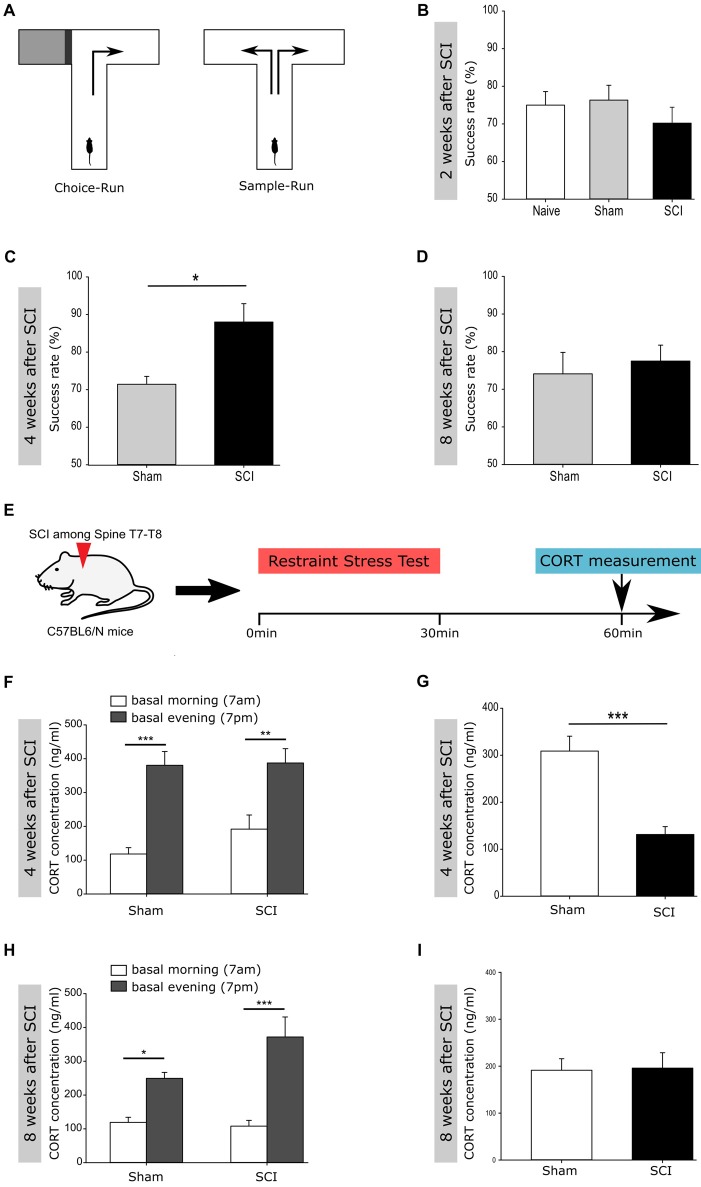
Improved performance in a Working Memory task and in buffering acute stress following spinal cord injury. (A) Experimental setup for the spontaneous alternation in the T-Maze test. (B) Success rate 2 weeks post injury of naïve vs. sham vs. SCI mice (75% ± 3.29 vs. 76.34% ± 3.80 vs. 70.19% ± 4.09); nnaive = 6 vs. nsham = 14 vs. nSCI = 13. (C) Success rate 4 weeks post injury of sham vs. SCI mice (71.43% ± 5.15 vs. 88% ± 4.38); group size, nsham = 7 vs. nSCI = 5; Mann-Whitney Rank Sum Test. (D) Success rate 8 weeks post injury of sham vs. SCI mice (74.11% ± 5.27 vs. 77.5% ± 3.79); group size, nsham = 7 vs. nSCI = 5. (E) Experimental setup to perform the restraint stress test. (F) Basal corticosterone (CORT) concentration 4 weeks post injury in shammorning vs. shamevening (118.2 ± 18.7 vs. 380.6 ± 40.9 ng/ml) and SCImorning vs. SCIevening (191.7 ± 42 vs. 387.5 ± 42.3 ng/ml); nsham = 14 vs. nSCI = 14; one way ANOVA. (G) CORT concentration 4 weeks post injury after the restraint stress test in sham vs. SCI mice (309 ± 31.6 vs. 131.3 ± 16.8 ng/ml); nsham = 14 vs. nSCI = 14; Mann-Whitney Rank Sum Test. (H) Basal CORT concentration 8 weeks post SCI in shammorning vs. shamevening (119 ± 15.2 vs. 249.5 ± 17.6 ng/ml) and SCImorning vs. SCIevening (108 ± 17 vs. 371.9 ± 59.1 ng/ml); nsham = 13 vs. nSCI = 13; one way ANOVA. (I) CORT concentration 8 weeks post SCI after the restraint stress test in sham vs. SCI mice (191.4 ± 24.6 vs. 196 ± 32.8 ng/ml); nsham = 13 vs. nSCI = 13. All mice were 12 weeks old at the time of injury/sham-injury. Succes rate and CORT concentration are given as mean values (±SEM); *p < 0.05, **p < 0.01, ***p < 0.001.